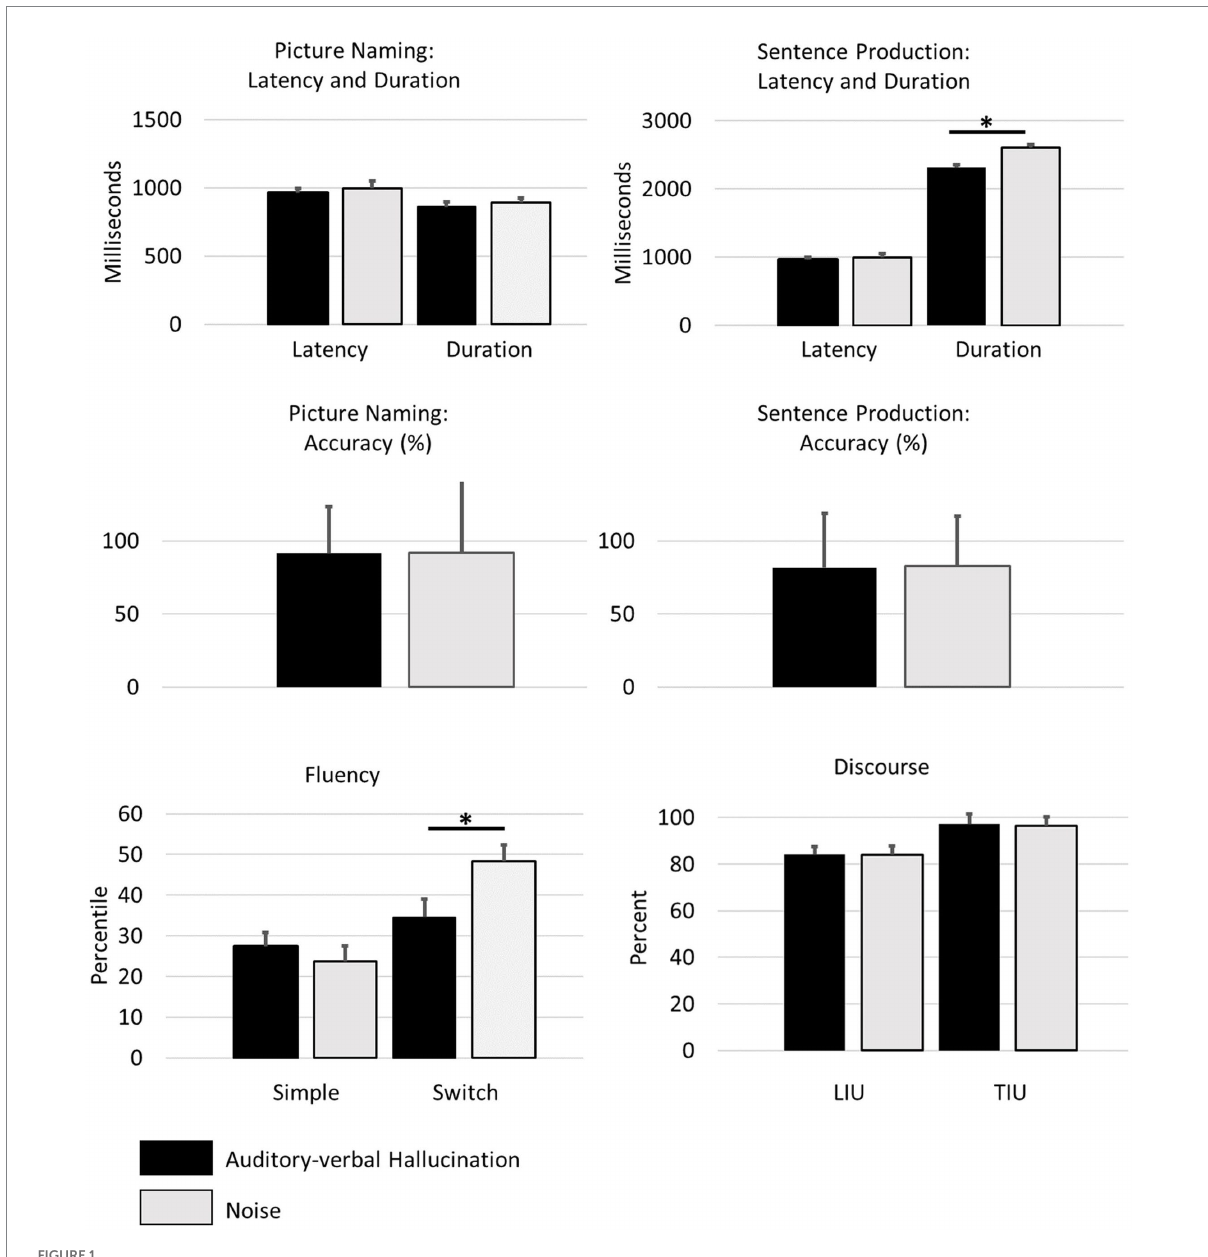
FIGURE 1 Average performance in the different language production tasks under auditory-verbal hallucinations (black) and noise (grey). Error bars indicate the standard error of the mean. * p < 0.05 corrected for multiple comparisons within the